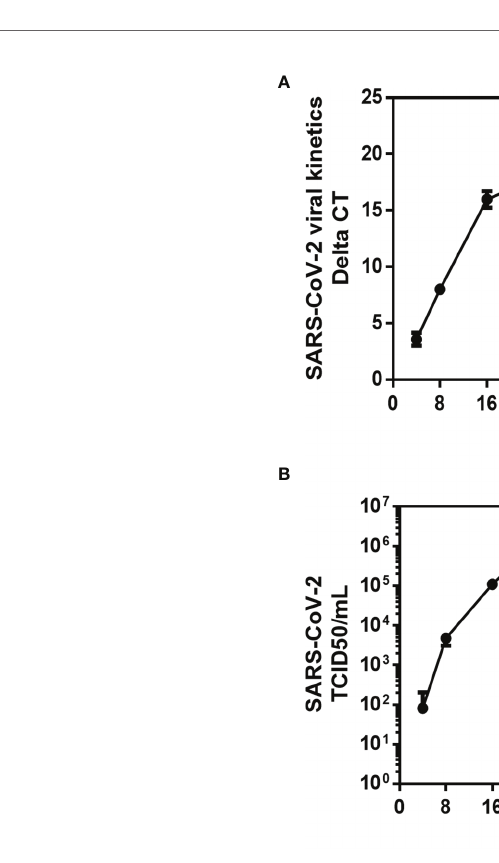
FIGURE 2 | Kinetics of SARS-CoV-2 infection in Caco-2 cells. After viral inoculation in Caco-2 cells, the viral release was monitored over 72 hours (T=0, 4h, 8h, 16h, 24h, 48h, and 72h) from the cell ’ s supernatant. (A) Quanti fi cation of the viral release from Caco-2 cell by qRT-PCR: D CT represents the CT value obtained subtracted from the CT value at time T=0 (CT - CT 0 ), where T=0 is the moment immediately after removing the inoculum used in the adsorption step. Each value is the mean of triplicates (B) Quanti fi cation of SARS-CoV-2 infectious particles released in the supernatant of Caco-2. The TCID 50 was performed by inoculating supernatants collected from SARS-CoV-2 infected Caco-2 cells into a culture of Vero E6 cells. The cytopathic effect (CPE) was evaluated on Vero E6 cells at 7 days after exposure to Caco-2 culture supernatants. Each value is the mean of triplicates. The TCID 50 /mL is calculated according to the Spearman and Kärber